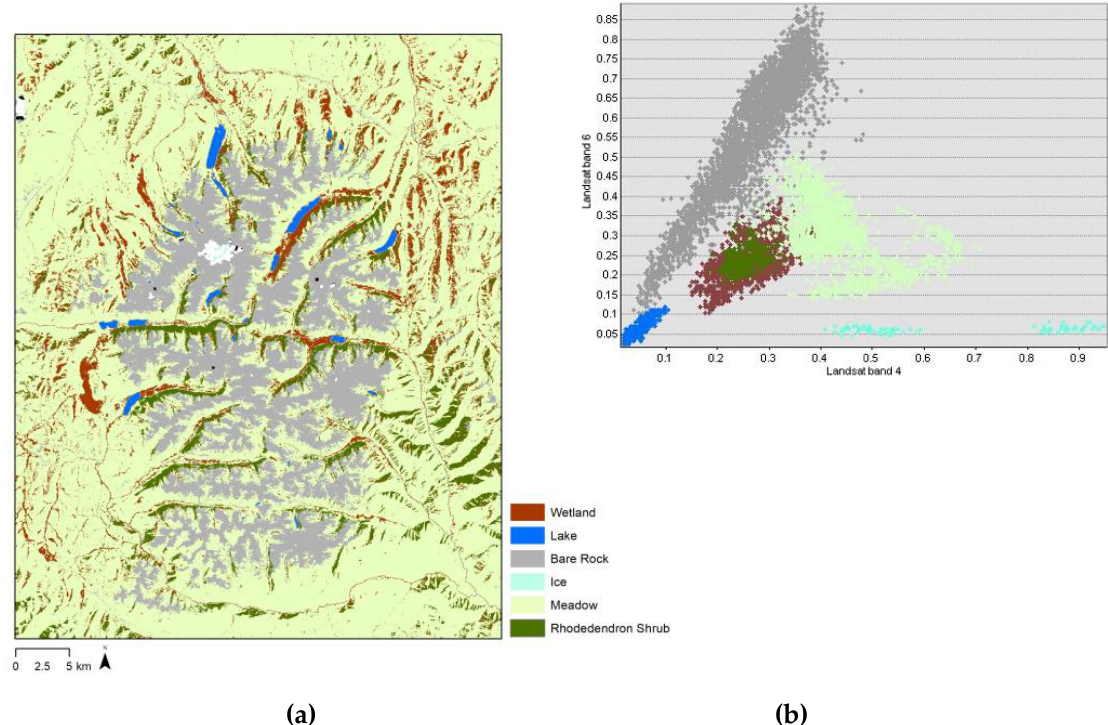
Figure 4. ( a ) Maximum-likelihood classification results of Landsat 5 TM image over the study area on 6 August 2004. ( b ) The scatterplot of Landsat band 4 (near infrared) and band 6 (thermal infra- red).